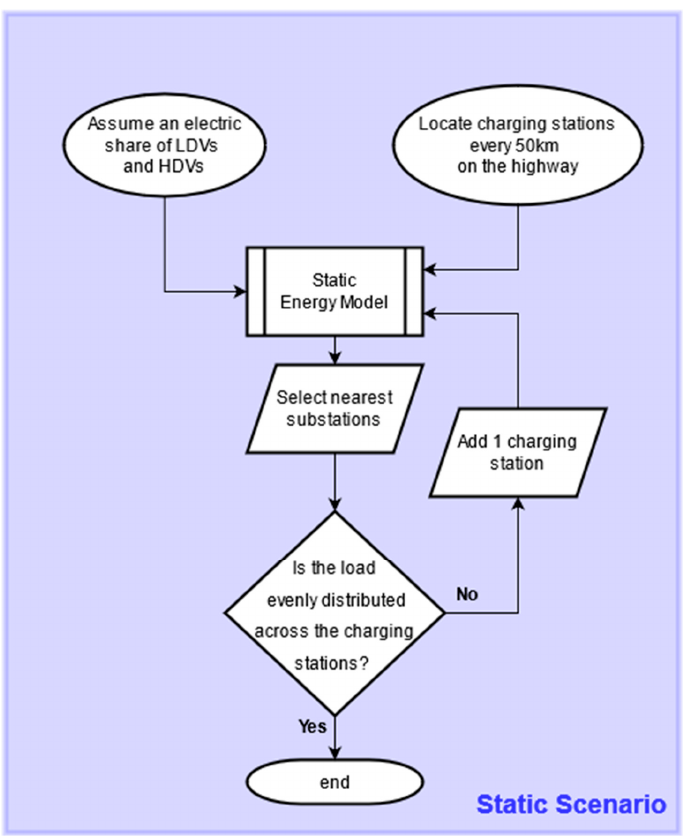
Figure 1. Methodology for the static